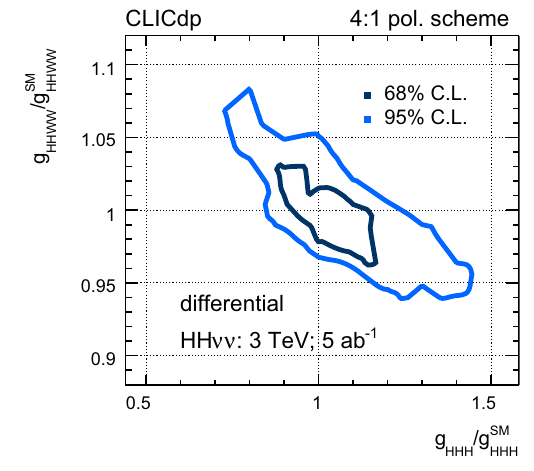
Fig. 10 Confidence contours at 68% and 95%C.L. for the simultane- ous fit of κ HHH and κ HHWW based on differential measurement in HH ν ¯ ν production at 3TeV